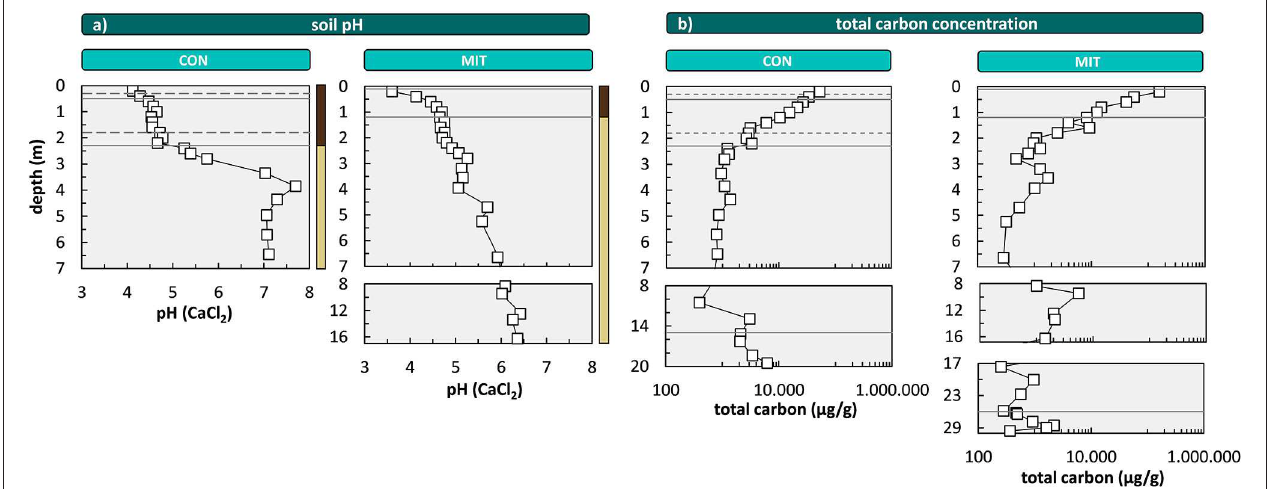
FIGURE 7 | Depth distribution of the soil pH (a) and depth distribution of total carbon concentrations (b) at CON and MIT. Soil pH is analyzed in 0.01M CaCl 2 . Solid lines illustrate soil horizon boundaries and the interface of weathered rock to unweathered rock. Dashed lines indicate soil horizon subdivision (see Figure 2 ). Colored bars at the right site of (a) refer to color coding of drill core sections from Figure 2 . For ease of display we changed the y-axis spacing with depth, yet all data are shown